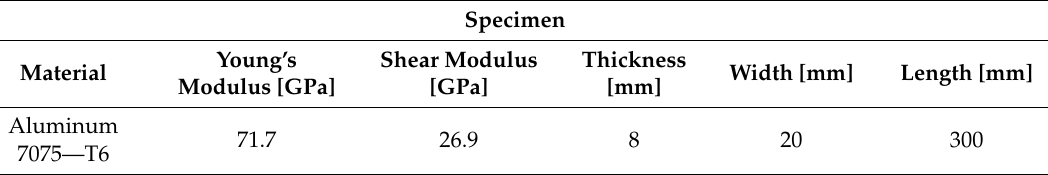
Table 3. Material properties and geometrical dimensions of the host